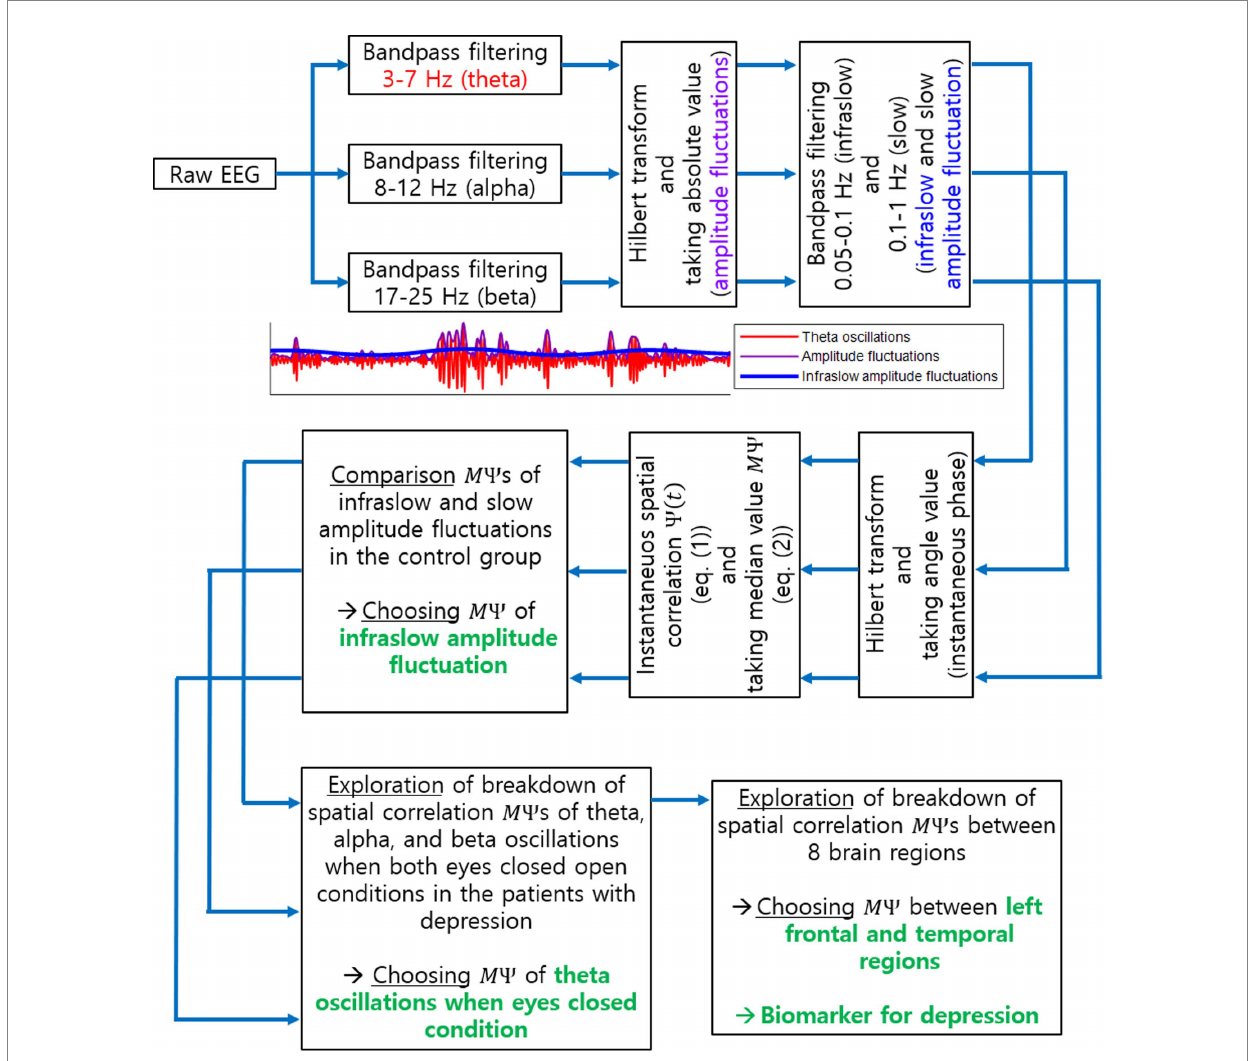
FIGURE 2 Procedure to explore a biomarker for current MDD using EEG spatial correlation. This illustrates all steps to identify the biomarker for current MDD as the breakdown of long-range spatial correlations. Specific EEG oscillation frequency band, task condition and brain regions, identified as a result of our investigation, are also illustrated in